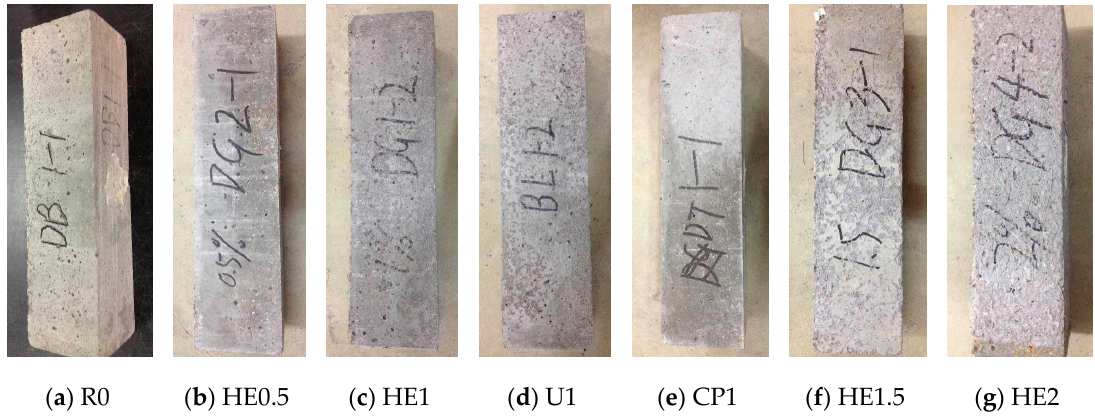
Figure 8. Surface damage of steel-fiber-reinforced CGAC.